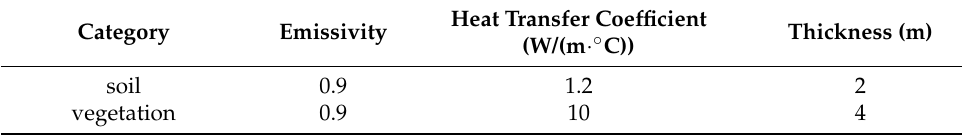
Table 4. Material property settings.